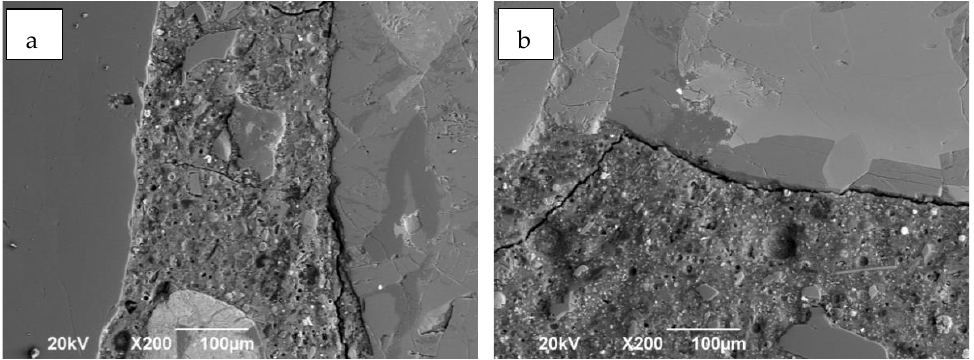
Figure 4. Observation matrix-aggregate interface. ( a ) FA/GBFS y ( b ) FA/OPC.